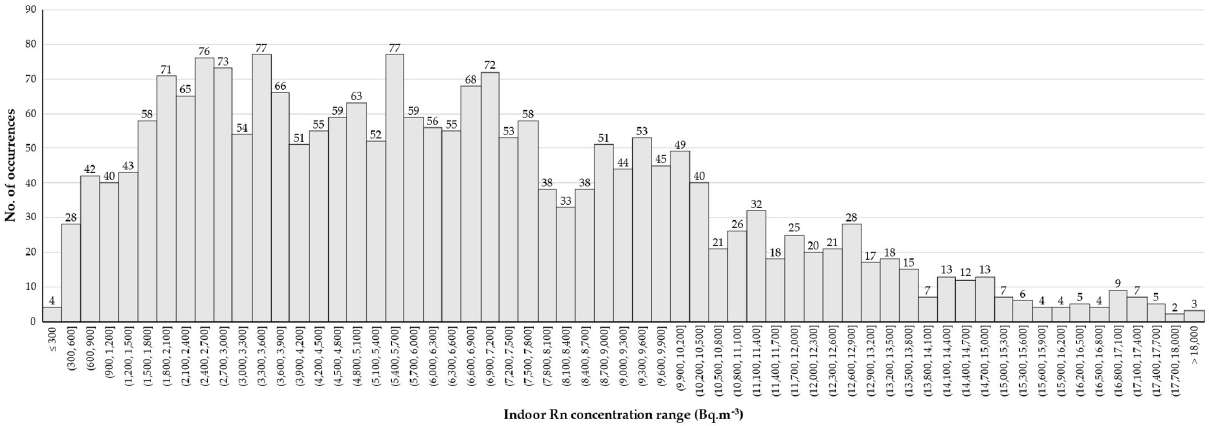
Figure 5. Distribution of measurements made in the preliminary assessment of Rn concentration in the compartment.